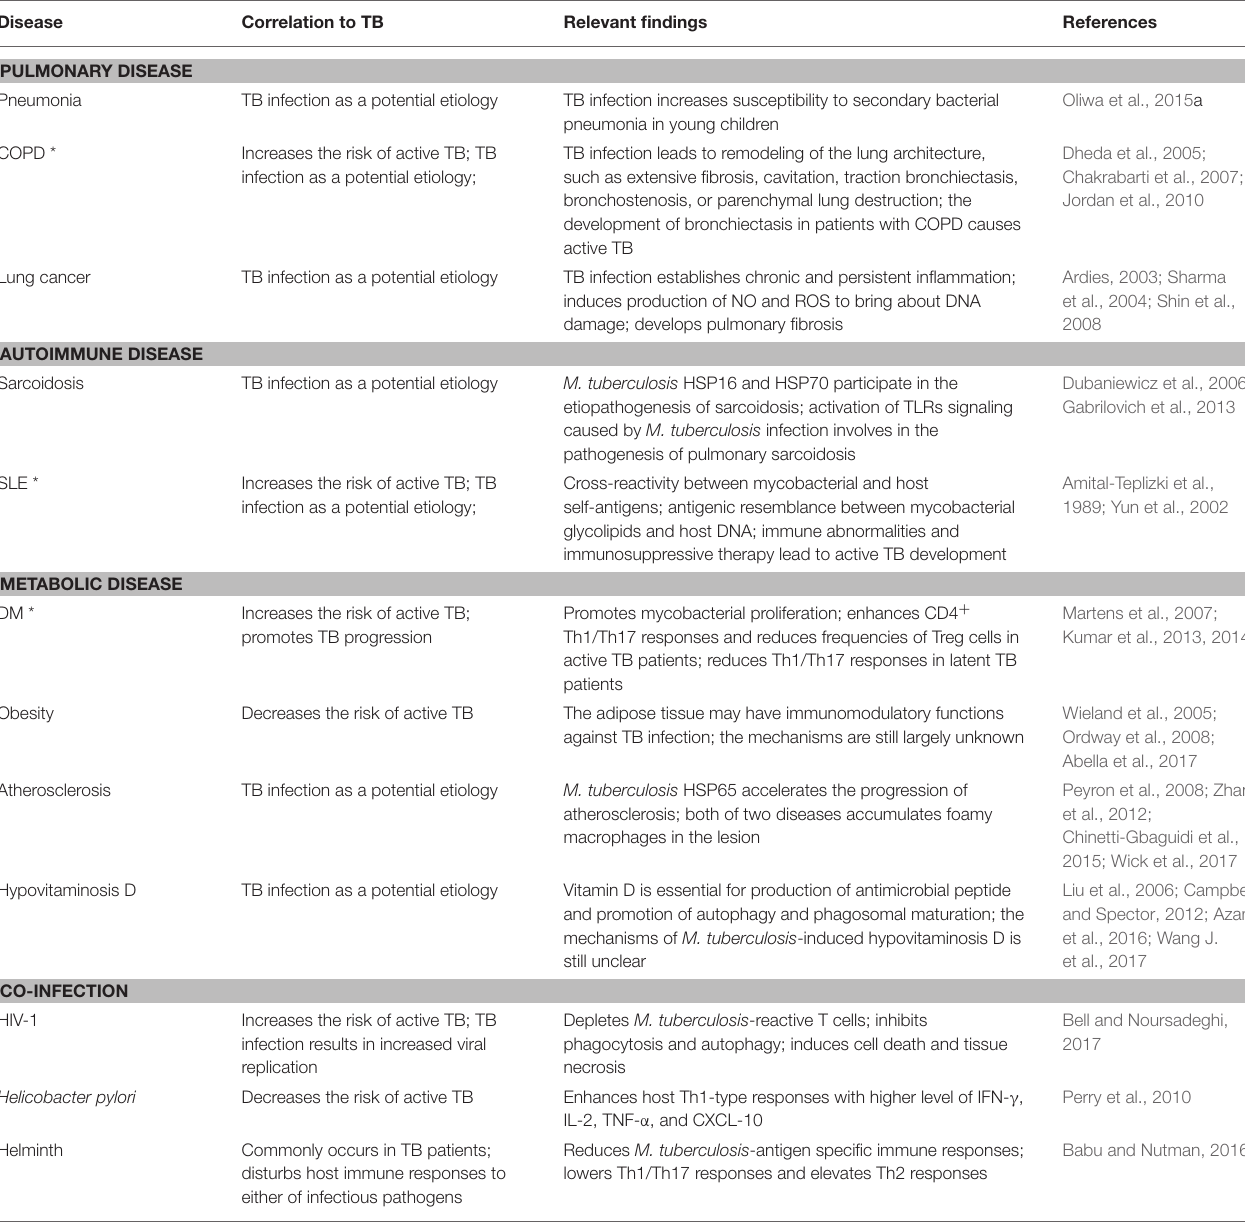
TABLE 2 | Examples of studies on mechanisms underlying the interaction between TB infection and multiple human diseases.